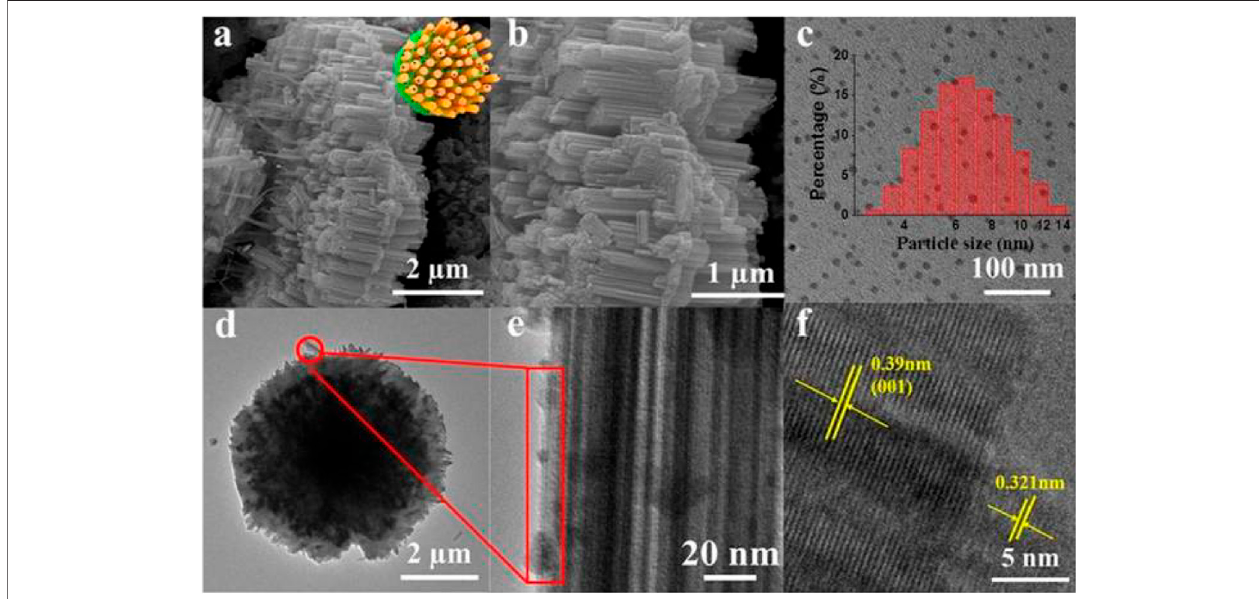
FIGURE 6 | SEM and TEM of N,Fe-CDs; N,Fe-CDs/G-WO3-0.6 composite. (A,B) SEM of N,Fe-CDs/G-WO3-0.6; (C) TEM of N,Fe-CDs with the inset for the size distribution; (D) TEM of N,Fe-CDs/G-WO3-0.6; (E,F) HRTEM of N,Fe-CDs/G-WO3-0.6. (Reproduced from Ni et al., 2020, MDPI).